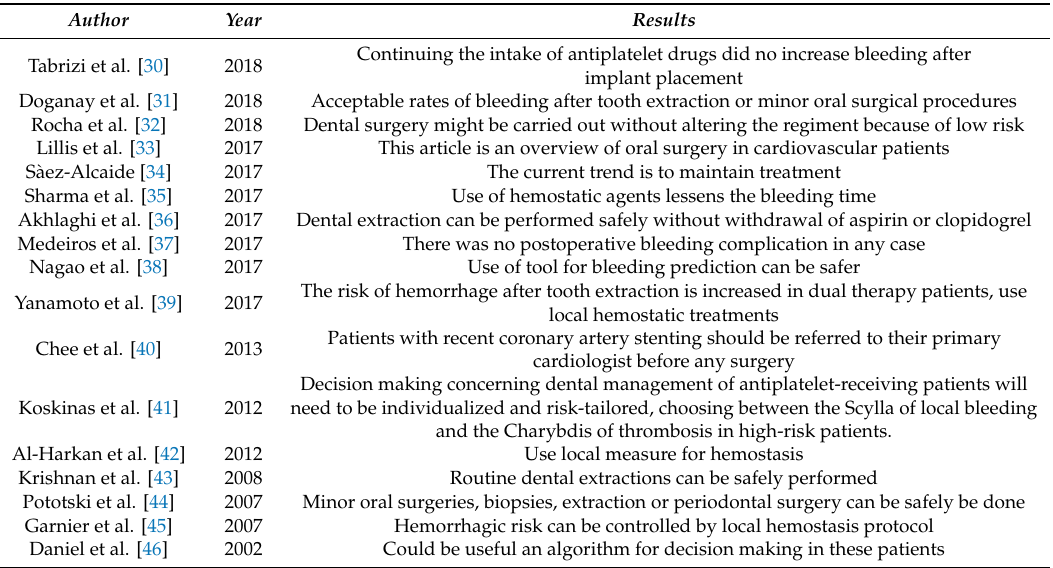
Table 3. Studies’